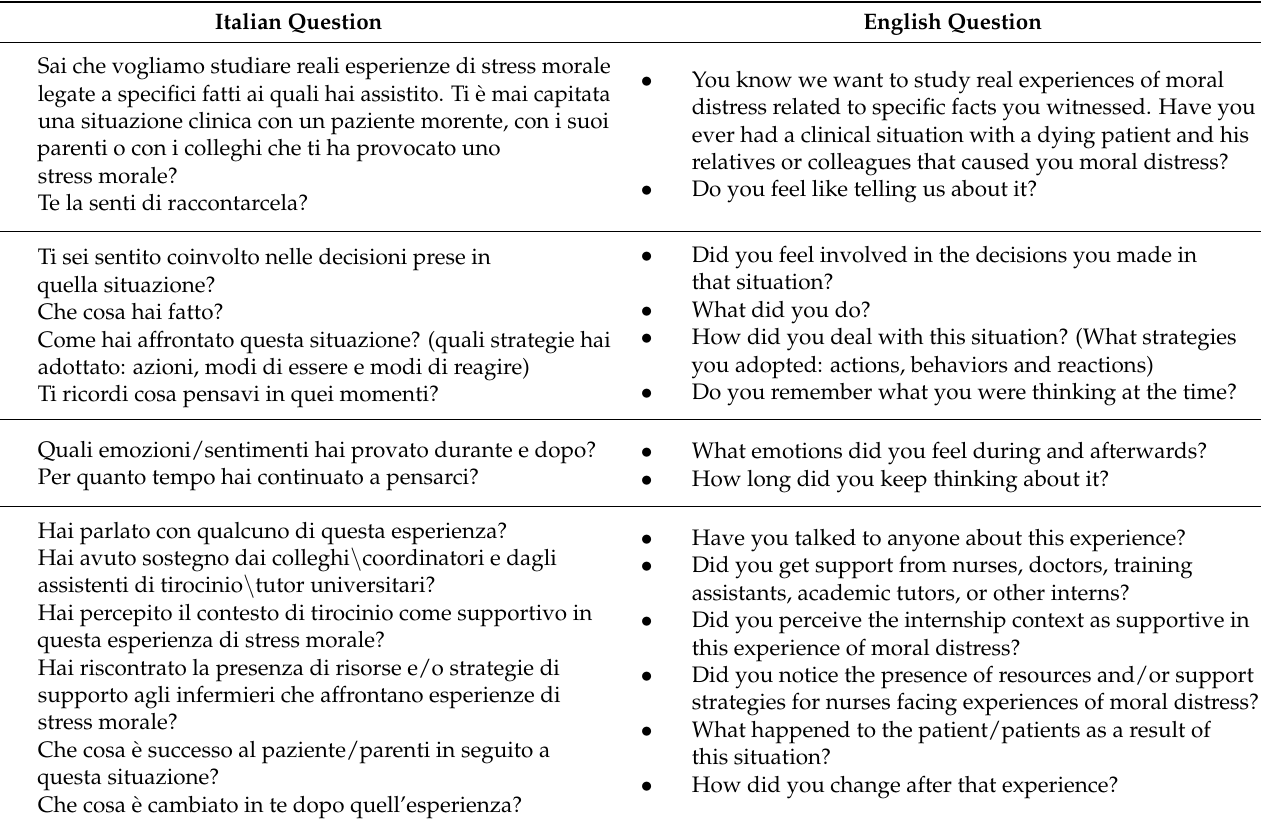
Table 1. The qualitative